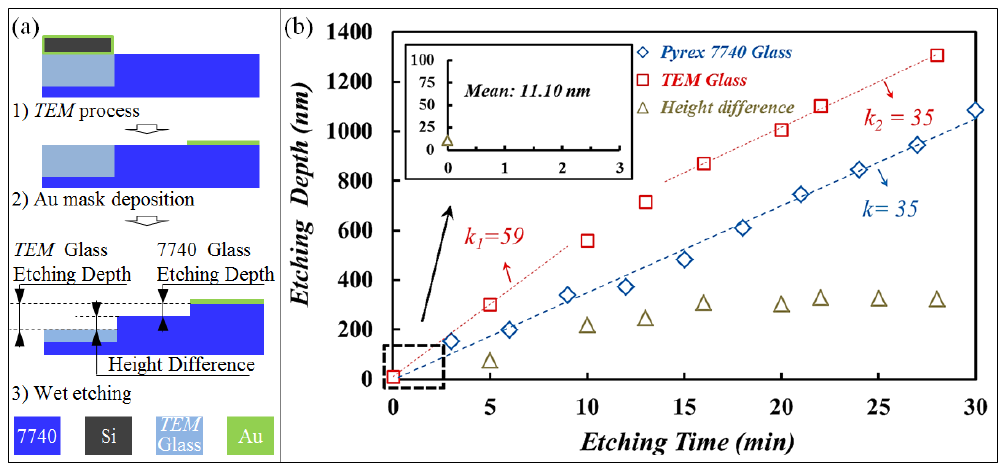
Figure 6. Etching depth of the TEM glass with 300 °C, 1000 V, and Pyrex 7740. ( a ) Etching flowchart; ( b ) Etching data.